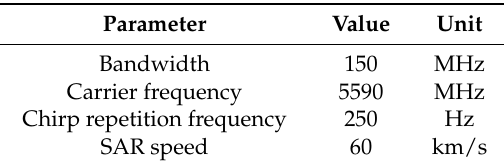
( b ) Figure 13. Real data processing results: ( a ) using traditional range migration algorithm (RMA) and ( b ) using proposed RMA.